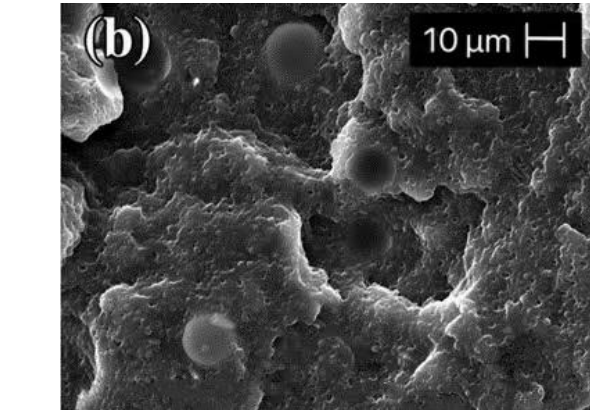
Figure 12. Interface diagram and partially enlarged figure of a composite without a coupling agent. ( a ) Mag = 460×; ( b ) Mag = 1415×. Adapted with permission [63], Copyright 2016, Springer.